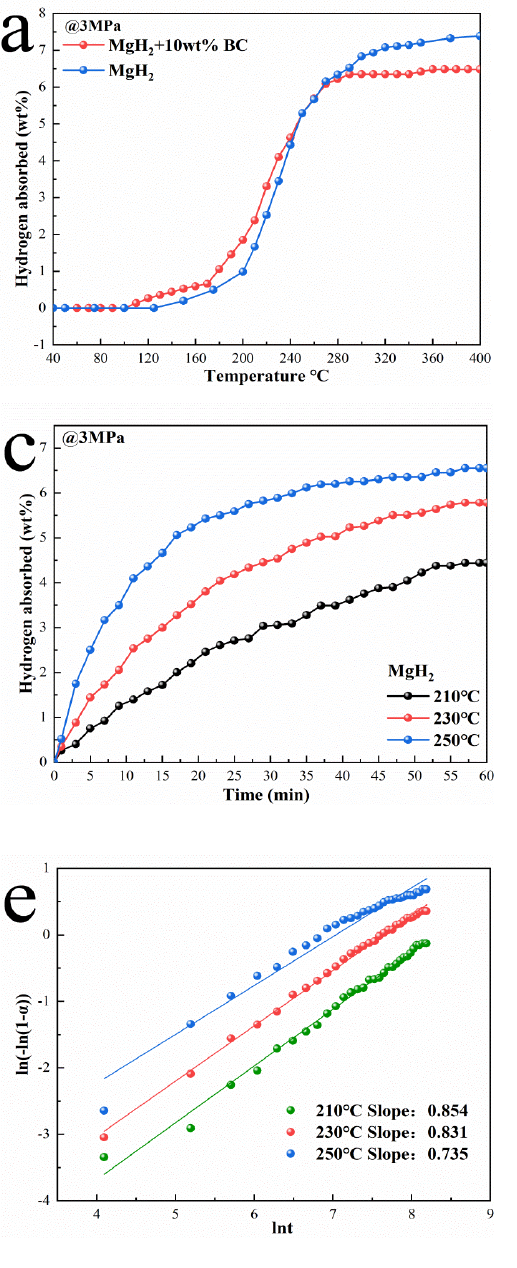
Figure 4. Non-isothermal hydrogenation curves of ( a ) MgH 2 + 10 wt% BC. Isothermal hydrogen absorption curves at different temperatures of ( b ) MgH 2 + 10 wt% BC and ( c ) pure MgH 2 . JMAK plots for ( d ) MgH 2 + 10 wt% BC and ( e ) MgH 2 . Arrhenius plots for ( f ) MgH 2 and MgH 2 + 10 wt% BC.